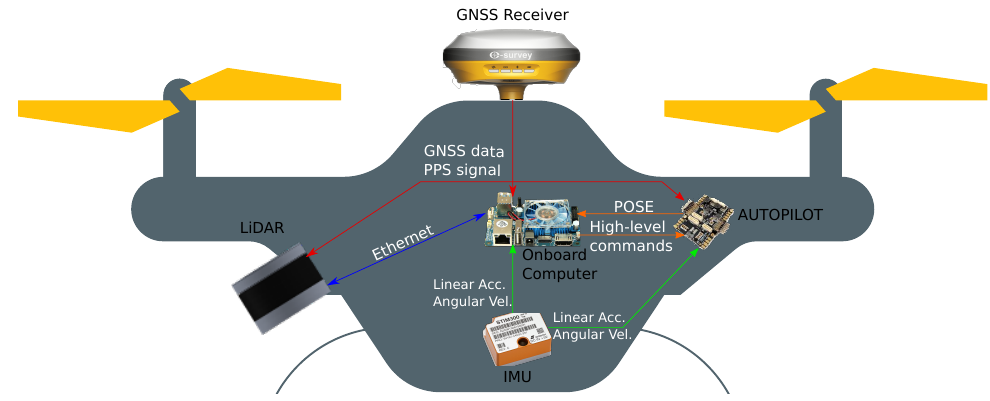
Figure 2. High-level hardware architecture (adapted from Refs.